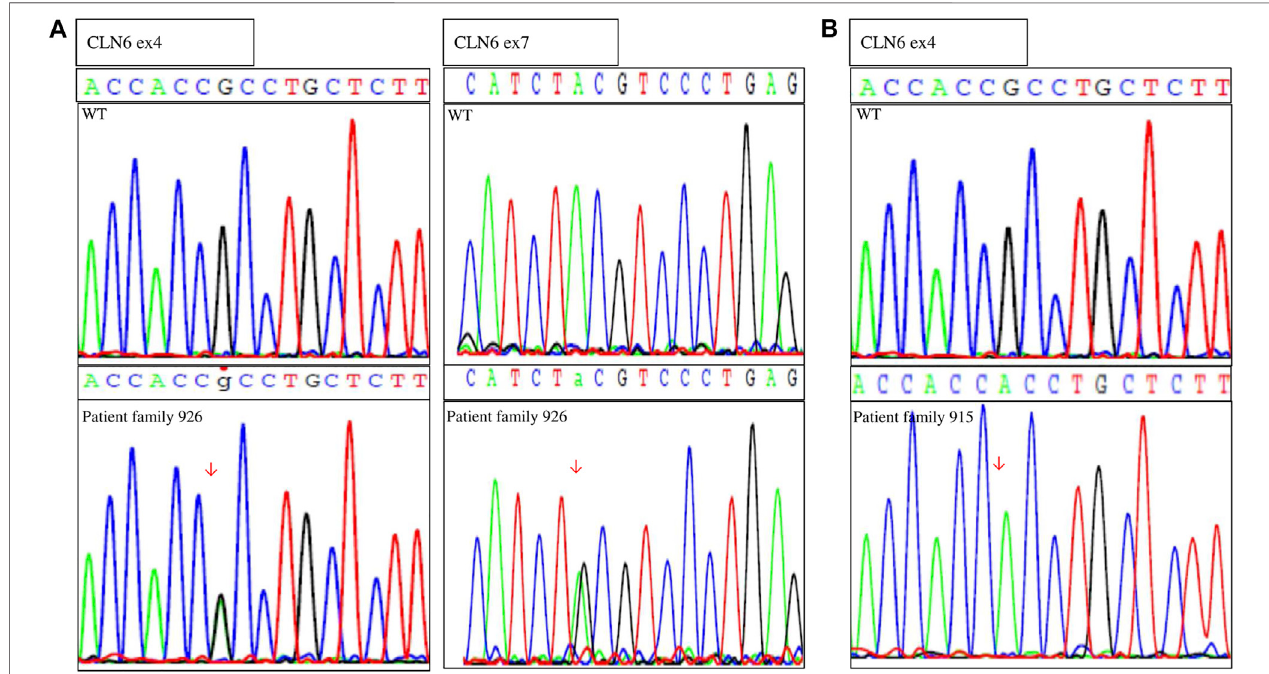
FIGURE 2 | Sequences showing the (A) compound heterozygous variants in genomic DNA of the proband (family 926) and the wild-type (WT) individual and (B) homozygous variant of the proband (family 915) and the WT individual.